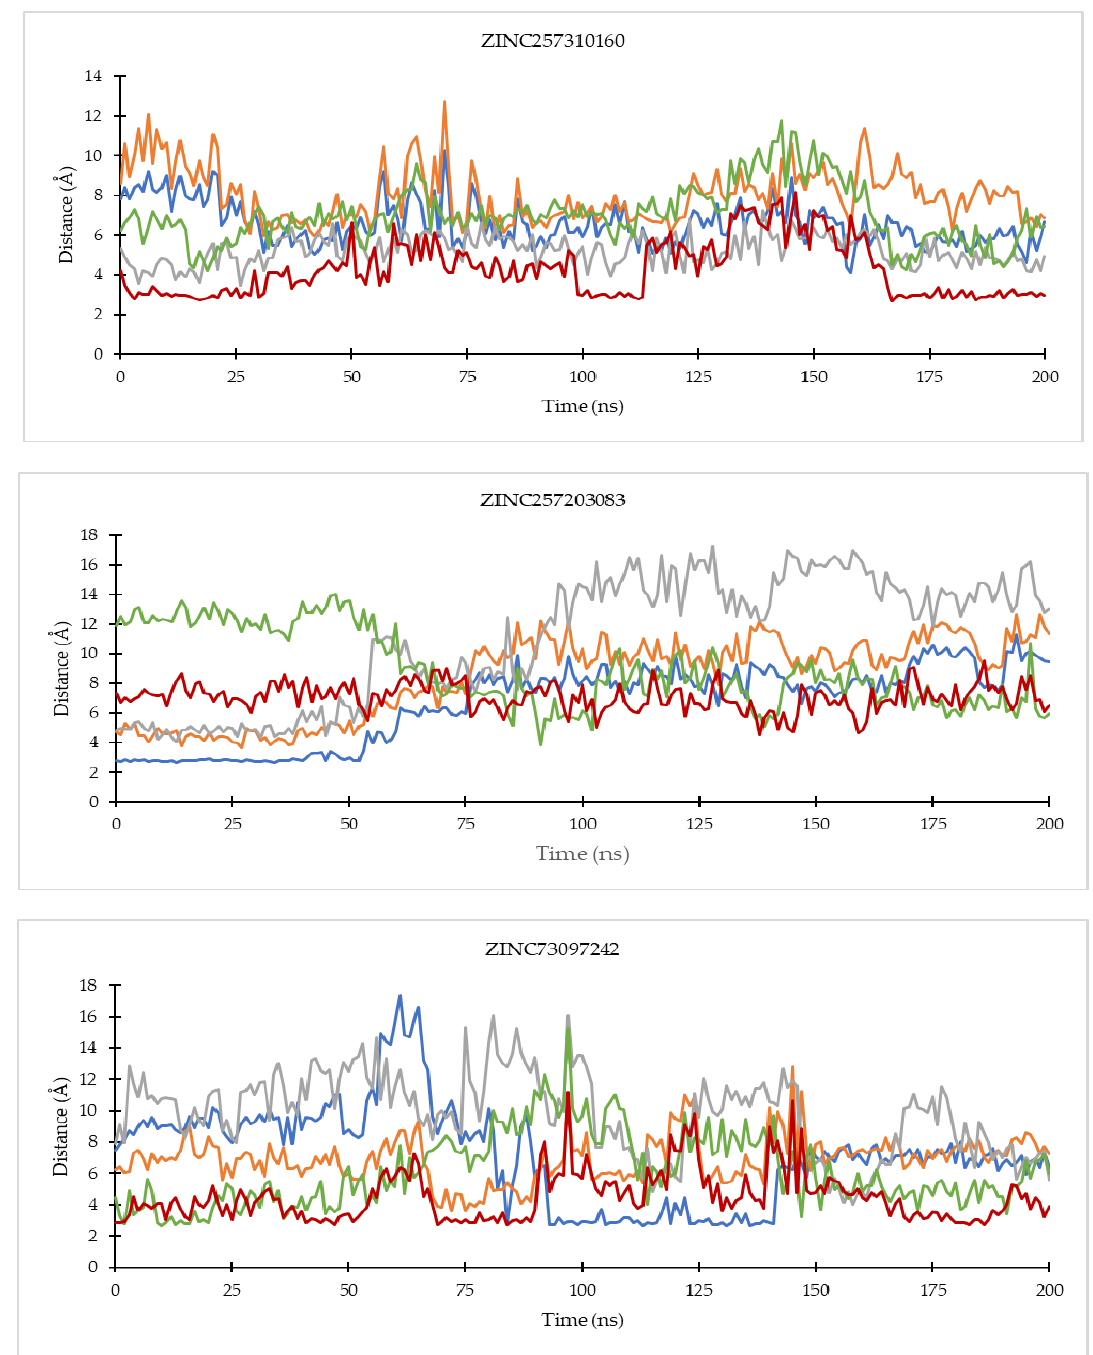
Figure 9. The evolution of the mean ligand–CDK6 residue distances of two replicas throughout the simulations. Color code: Blue: Val101; Orange: His100; Grey: Lys43; Green: Asp163; Red: Asp104.